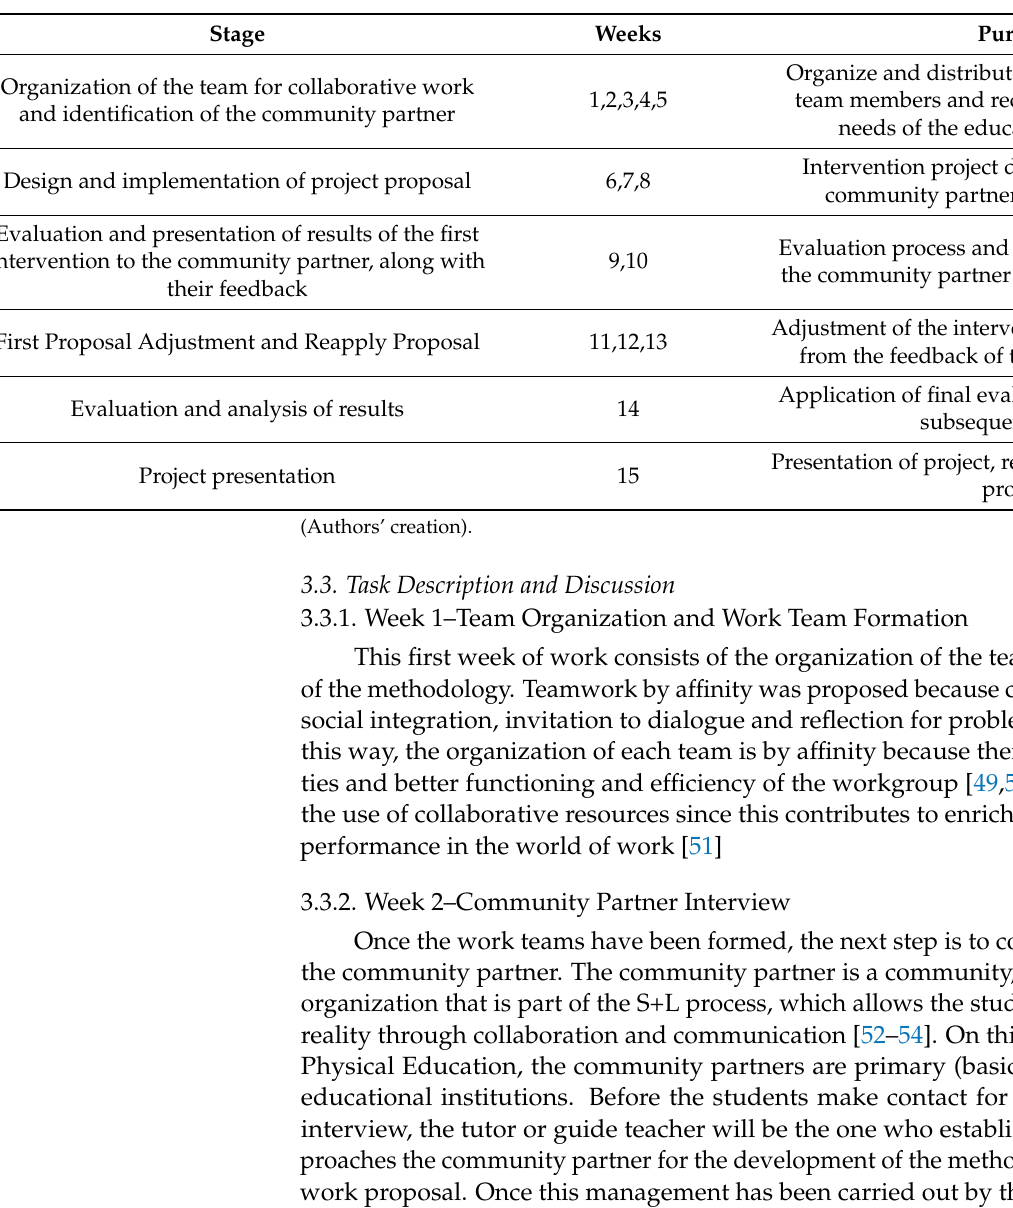
Table 2. Scheme of work for the development of the S+L